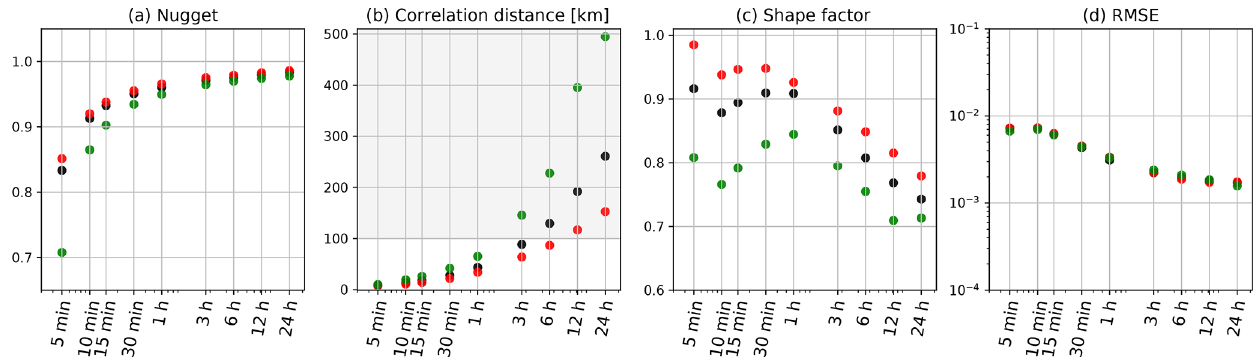
Figure 4. Dependence of (a) nugget effect, (b) correlation distance, and (c) shape factor of the fitted exponential functions on timescale; (d) shows RMSE of fitted correlation values compared to observed values (red: warm season; green: cold season; black: all months). Note that the correlation distance values over 100km (shaded in grey) are highly affected by the model selected to estimate the values.